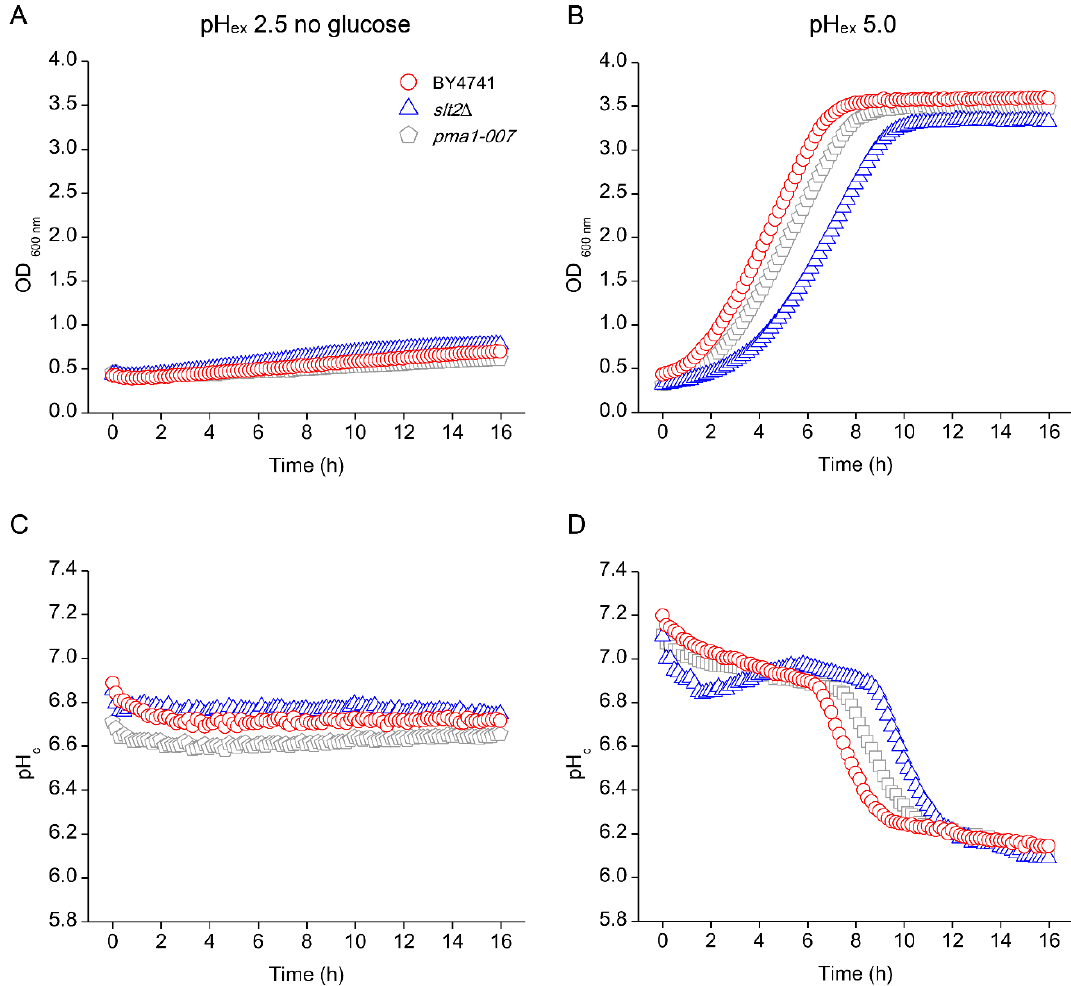
Figure 8. E ff ect of glucose starvation on the tolerance of S. cerevisiae to low external pH (pH ex ). Cells of S. cerevisiae BY4741 wild type strain (red circles) and its isogenic mutants slt2 ∆ (blue triangles) and pma1-007 (grey pentagon) were cultivated in glucose-lacking YNB adjusted with sulphuric acid to pH 2.5 for measurement of cell growth ( A ) and cytosolic pH (pH c ) ( C ). At the end of cultivations, cells were collected and transferred to glucose-containing YNB adjusted to pH 5.0 and cell growth ( B ) and pHc variation ( D ) were measured.